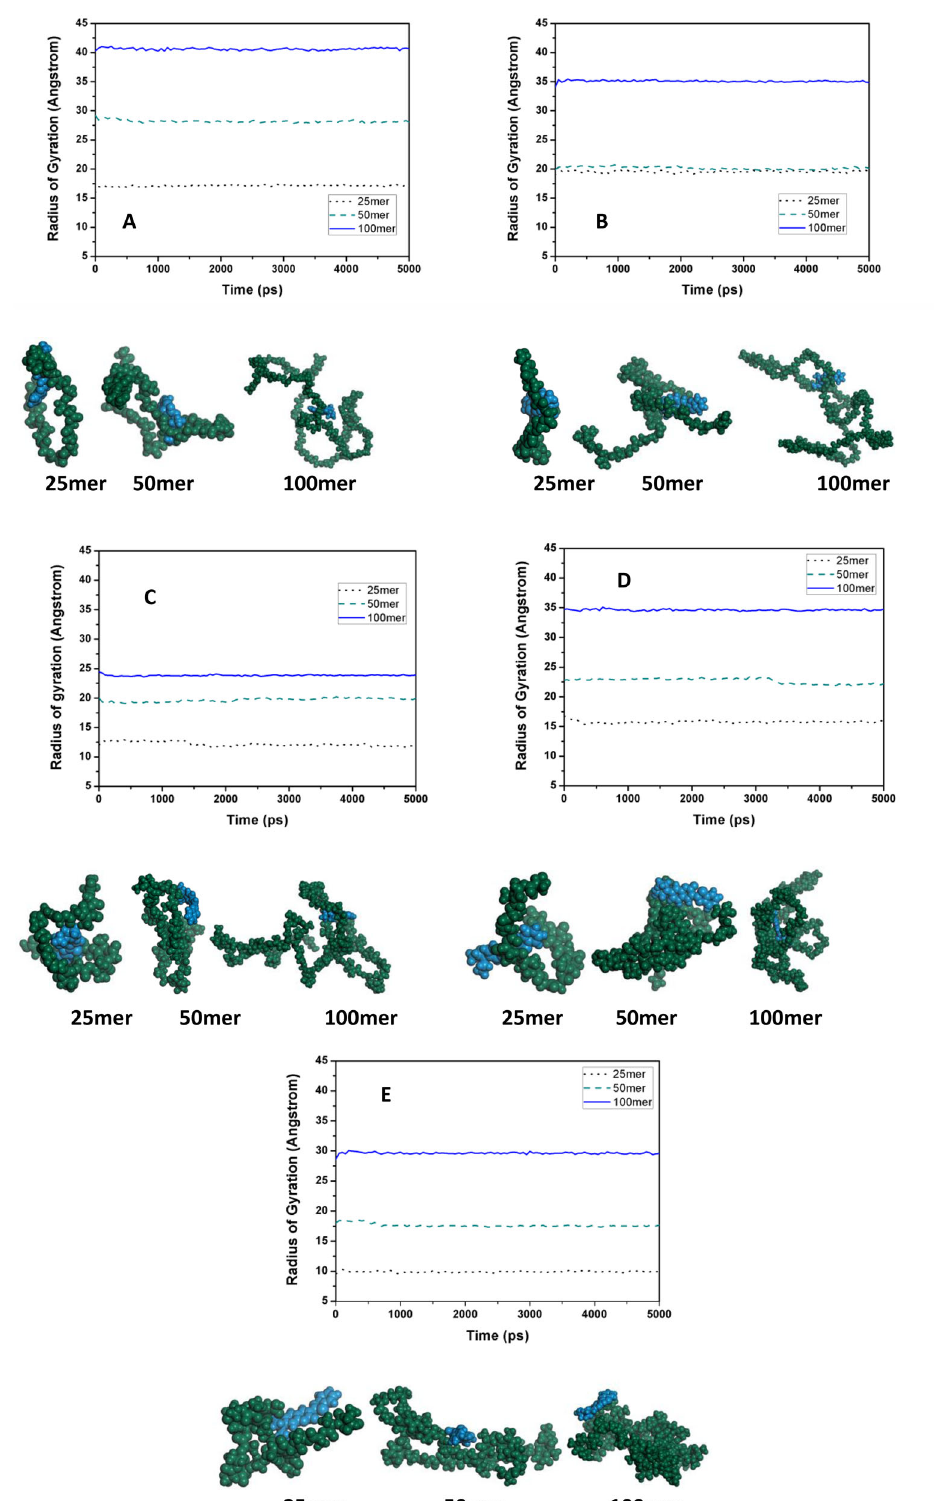
Fig. 11 Change in radius of gyration of the polymer chains during the course of simulation time of 5 ns for A PGA, B PLGA27, C PLGA55, D PLGA72, and E PLA. Below each graph, the geometry optimized